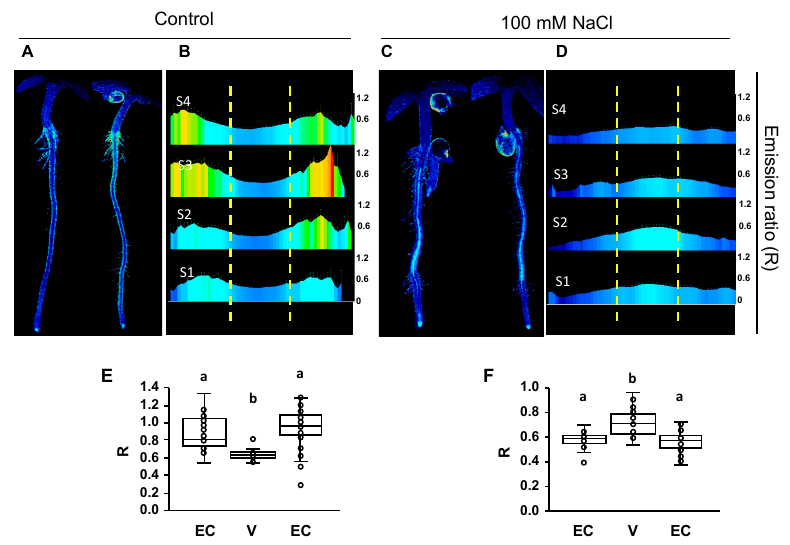
Figure 6. pHcyt maps of whole seedlings expressing the pH-sensor pHGFP-VTI11. Fluorescence emission ratios after sequential excitation at 405 and 488 nm (R) of pHGFP-VTI11 in 4-day-old seedlings 16 h after being transferred to LAK media ( A , B , E ) or LAK supplemented with 100 mM NaCl ( C , D , F ). ( A , C ) Representative seedlings grown in LAK medium ( A ) or LAK supplemented with NaCl ( C ). ( B , D ) Profile of root sectors showing average emission ratios (R) from at least 6 to 8 seedlings per treatment; the root zones S1 to S4 are named as in Supplemental Figure S3; the scales of R values are shown on the right; yellow lines indicate the division used to analyze the vasculature (center) and the epidermis and cortex (flanks). ( E , F ) Box plots indicating the mean of the emission ratios (R) in different tissues for each condition. The mean was obtained from the aggregated sectors S1–S4 shown in the images above. EC: epidermis and cortex; V: vasculature. Different letters indicate groups with significantly different values according to Tukey HSD test at p <